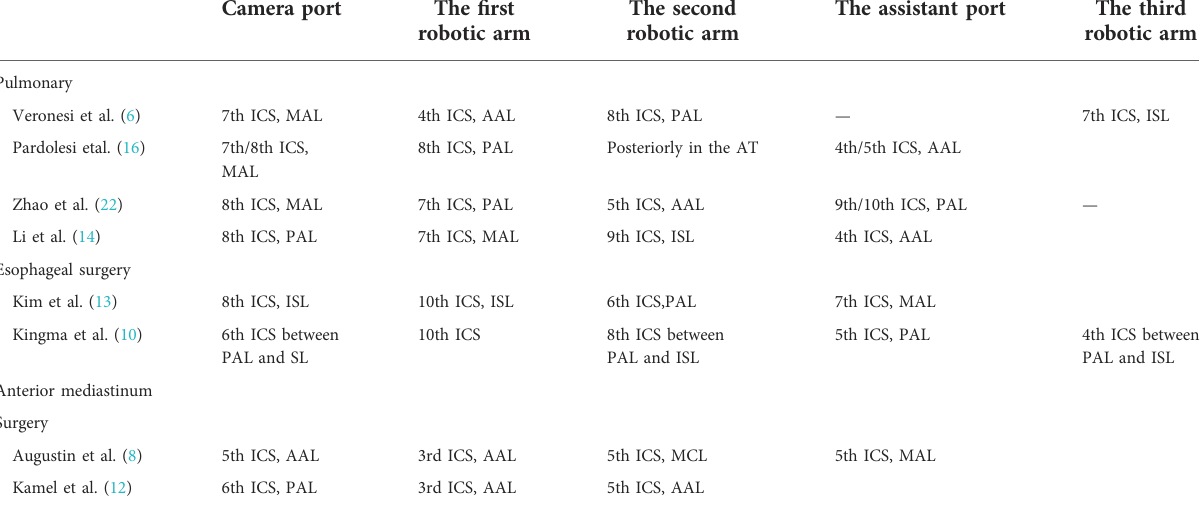
TABLE 3 A brief summary of the incisions for robot-assisted thoracic surgery.